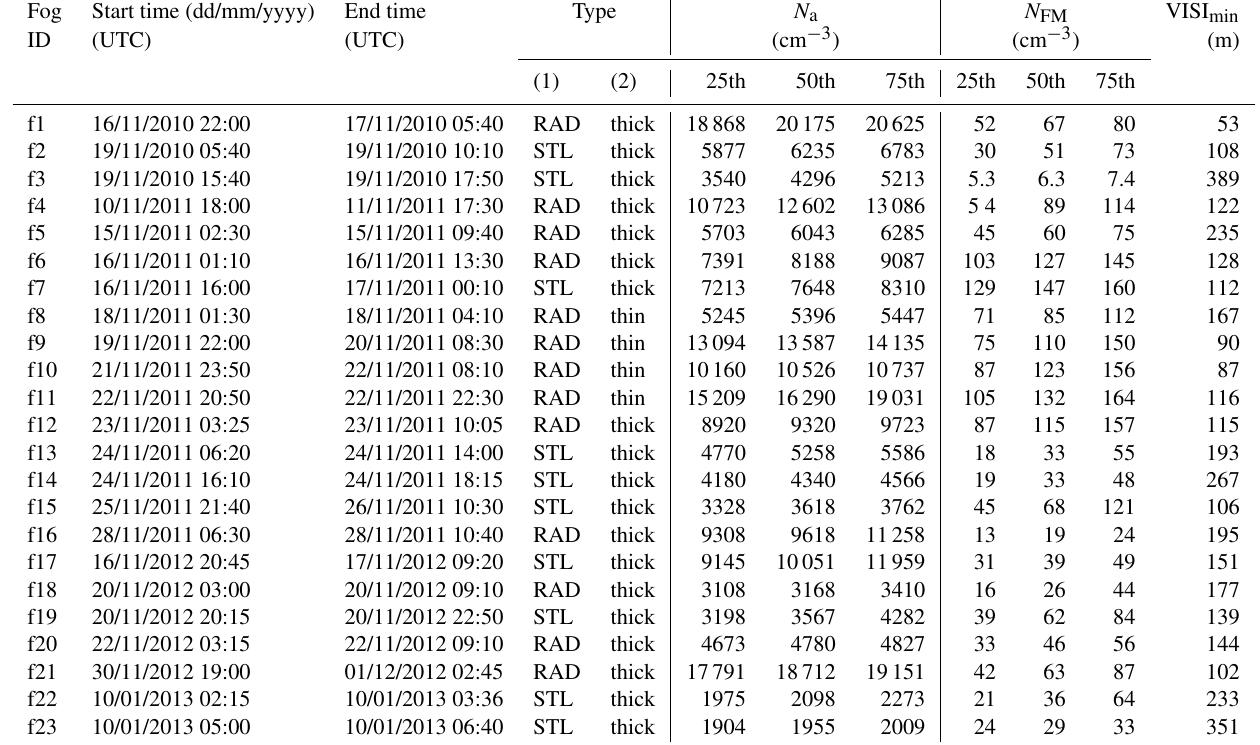
Table 2. List of fog events analyzed here. Type RAD corresponds to radiation fog and STL to stratus lowering, “thick” to fog developed on the vertical and “thin” to fog layer with top altitude lower than 18m. N a is the number concentration of aerosol particles derived from SMPS data. The 25th, 50th and 75th percentiles are computed from the distribution of 5min samples over the last hour before the fog beginning. N FM is the droplet number concentration as measured by the FM-100 over the range 2–50µm. Statistics of N FM are computed with minute average data of samples with LWC > 0.005gm − 3 collected during the whole fog event. The last column provides the minimum of visibility observed during the